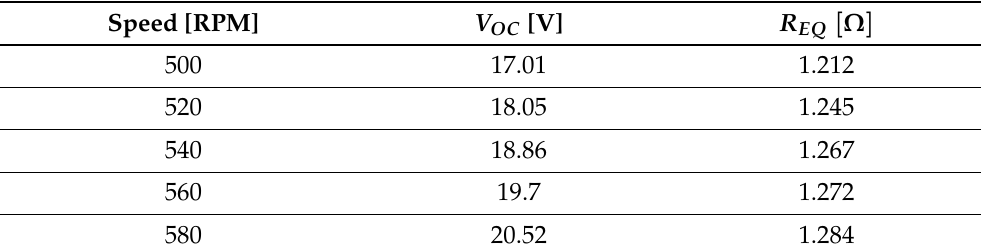
Table 1. Parameters for the Thevenin equivalent of the experimental